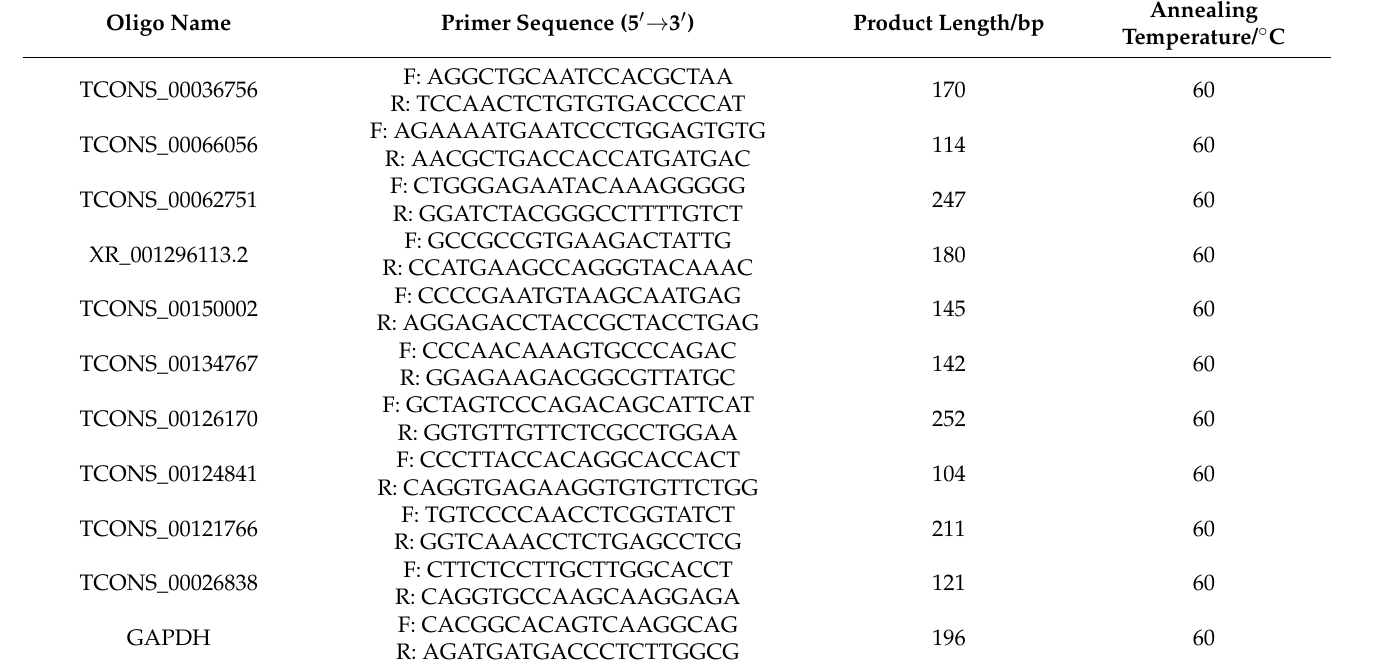
Table 1. Primer information of RT-qPCR used in the